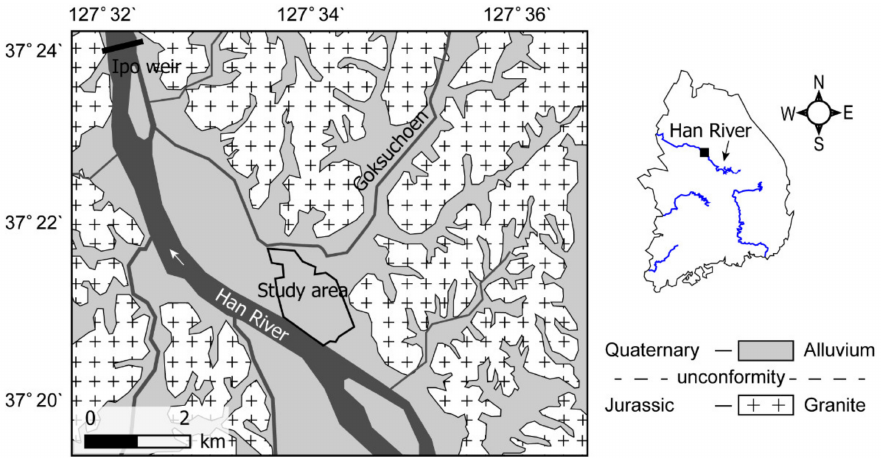
Figure 1. Location and geology of the study area in Han River Basin, South Korea (modified from [23]).